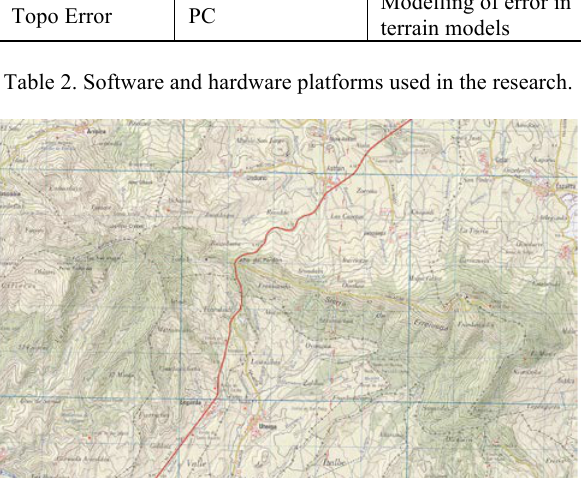
Figure 4. Sierra de Erreniega and Alto del Perdón. National Topographic Map, original scale 1:50.000. Sheet 141, det. (Instituto Geográfico Nacional, Madrid, Spain).